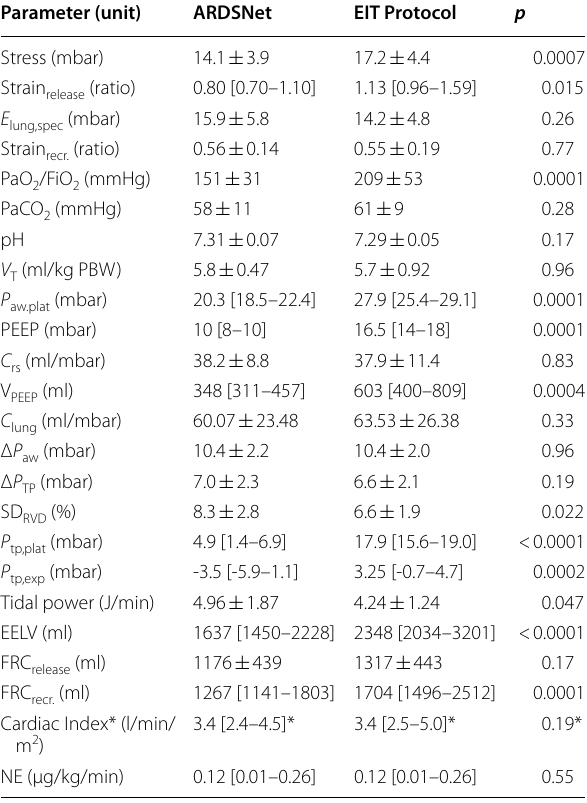
Table 2 Ventilator data and physiological parameters after mechanical ventilation according to the ARDS Network protocol low positive end-expiratory pressure (PEEP) table (ARDSNet) and after 4 h of mechanical ventilation according to the electrical impedance tomography based protocol (EIT